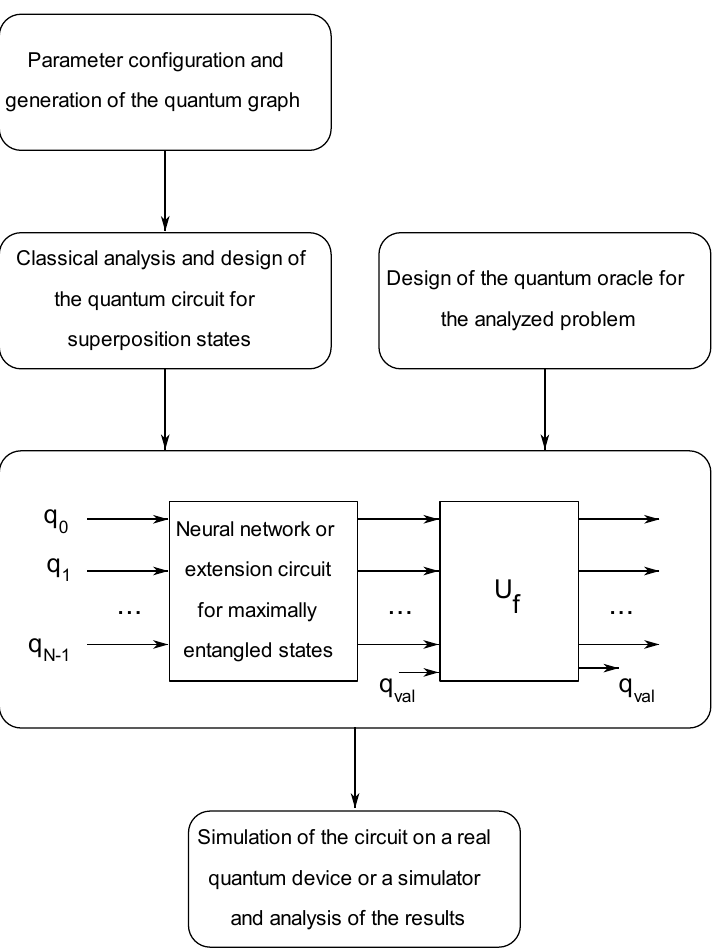
Figure 5. The scheme for the hybrid classical–quantum solution, integrating the main processing blocks (the neural network) with a quantum oracle.